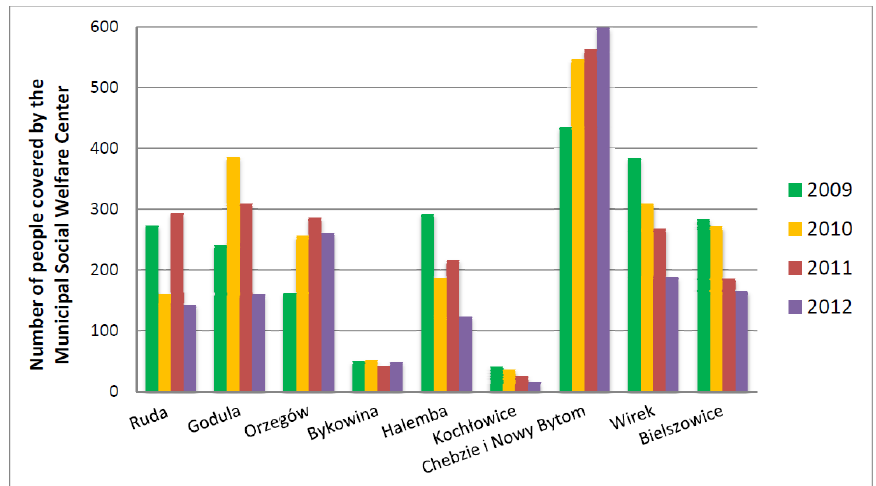
Fig. 5. Number of persons covered by the Social Welfare Centre (MOPS) for helplessness in matters of parental care and household maintenance in different districts of Ruda Śląska (own study, by www.mops.rsl.pl/monitor.html)